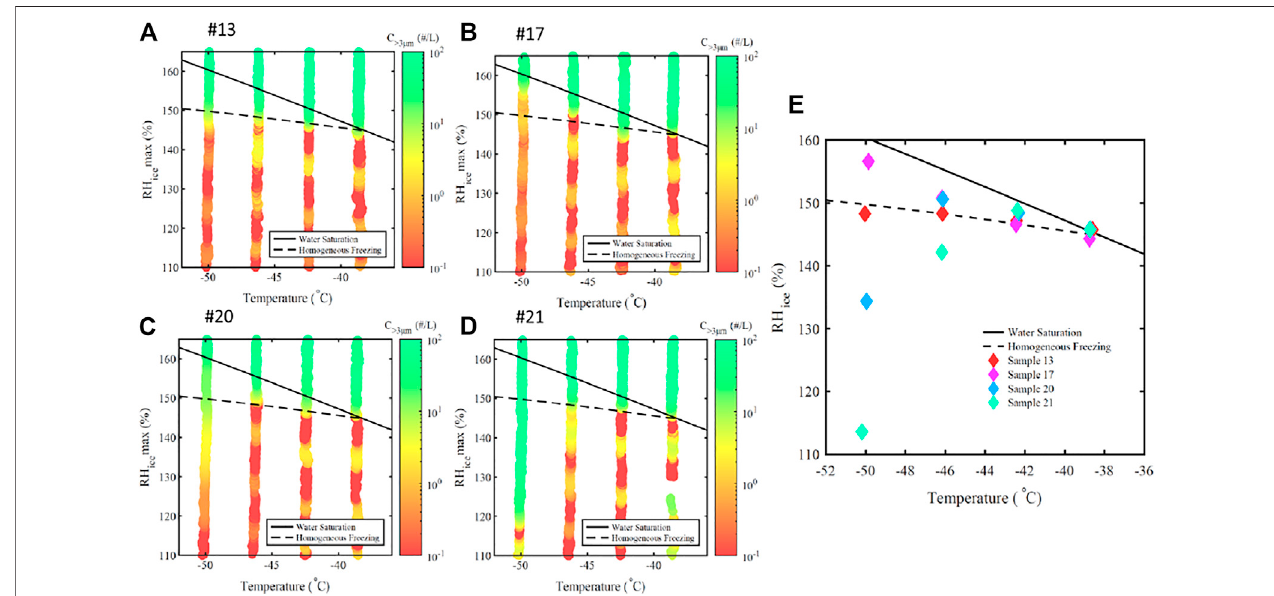
FIGURE 10 | (A – D) Particle concentrations observed in the OPC > 3 μ m size channel, indicative of ice active particles, plotted against maximum lamina supersaturations with respect to RH ice at different temperatures. During experiments, the RH was increased isothermally at 1% per minute. The heat map is used to emphasize ice nucleation onset — indicated by the transition to green. (E) Critical RH ice of ice nucleation onset. Water saturation is represented by the solid black line, while the dashed line represents homogeneous freezing of a solution ( J = 1.7 × 10 4 ) as given by Koop et al. (Koop et al.,